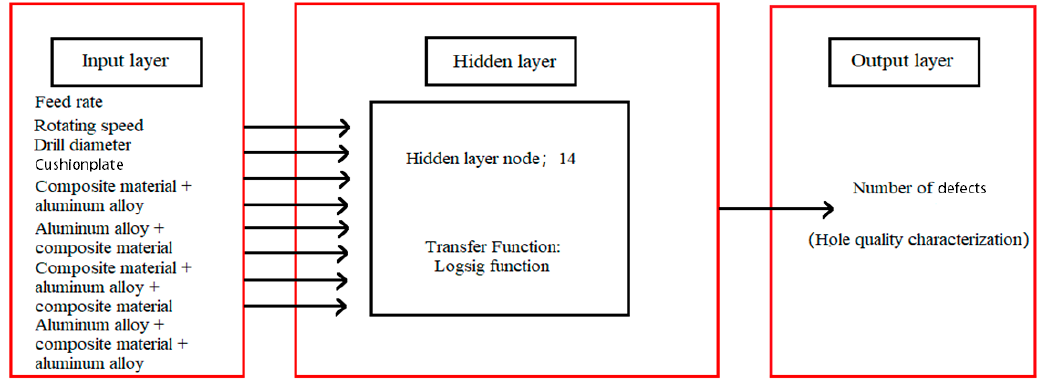
Figure 6. The three-layer topology of the prediction model.